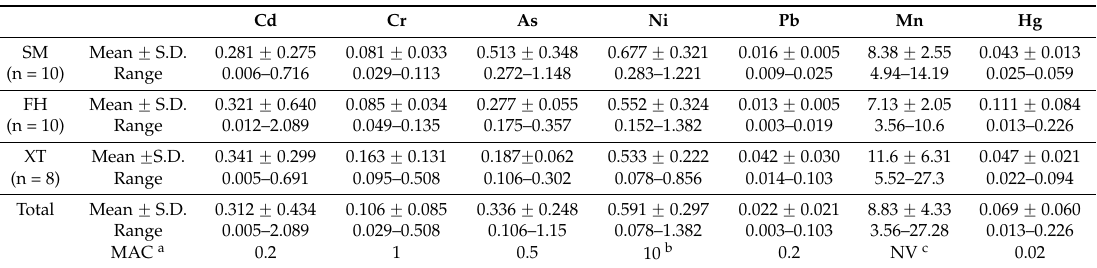
Table 4. Concentrations (mean ˘ standard deviation, mg/kg) of seven elements in brown rice from three districts in Hunan province.